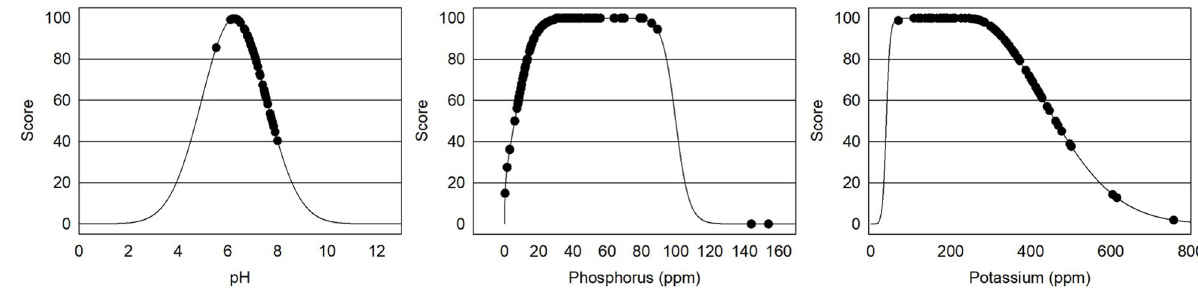
Fig 3. Soil fertility indicators: pH, P and K in 101 Central Washington orchards surveyed.